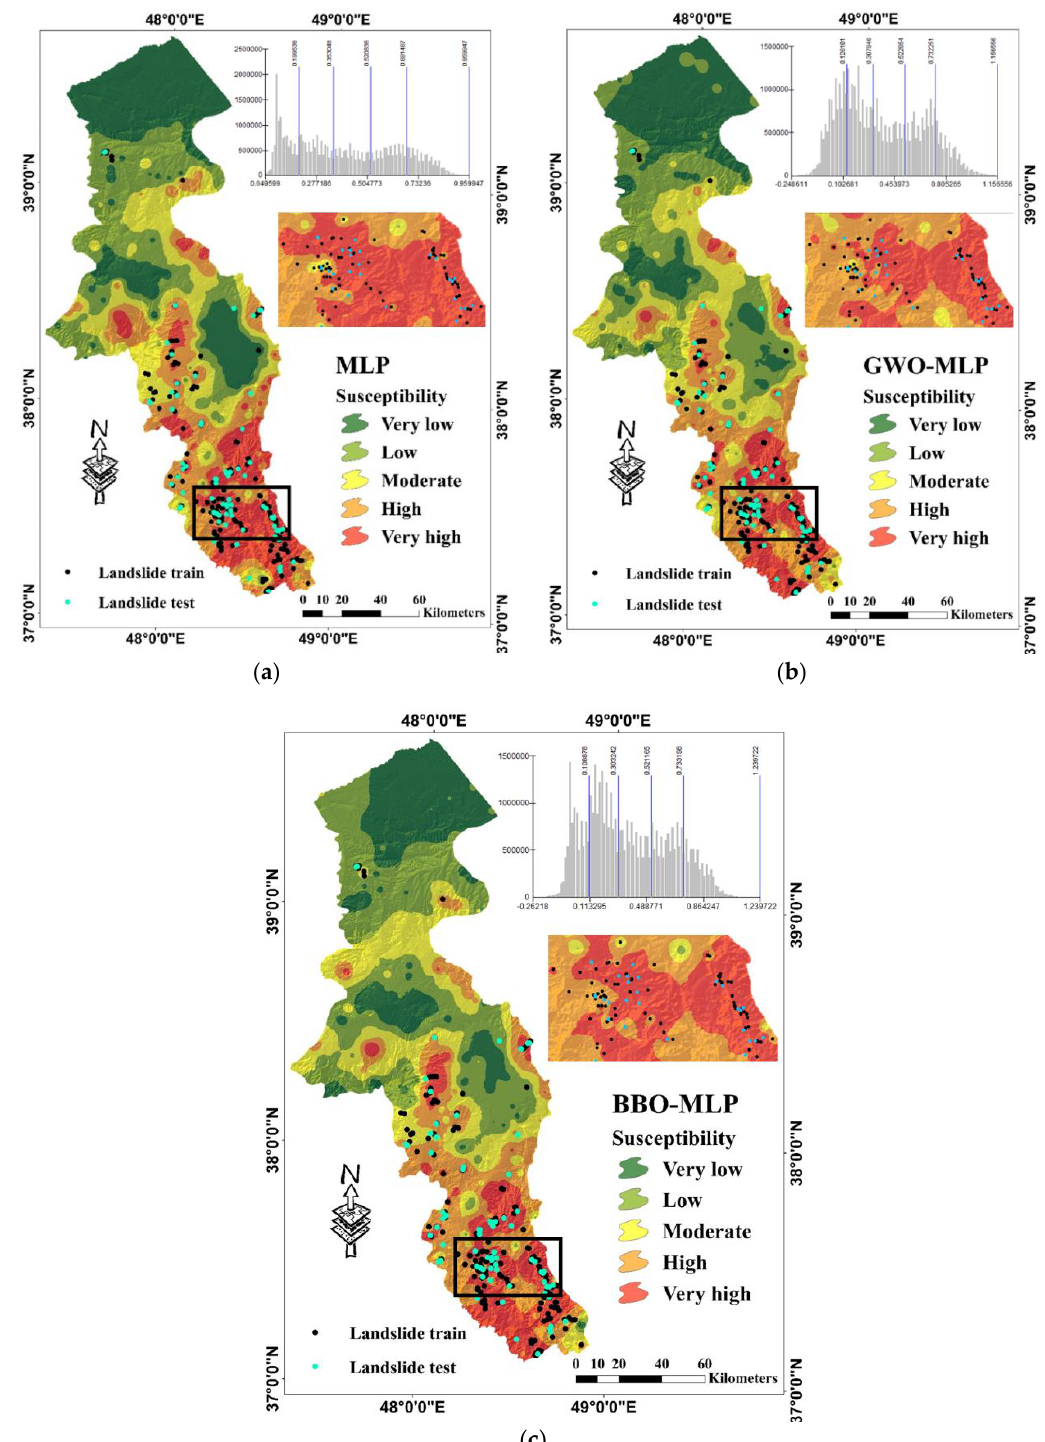
Figure 10. Landslide hazard map produced by ( a ) MLP, ( b ) GWO-MLP and ( c ) BBO-MLP models.